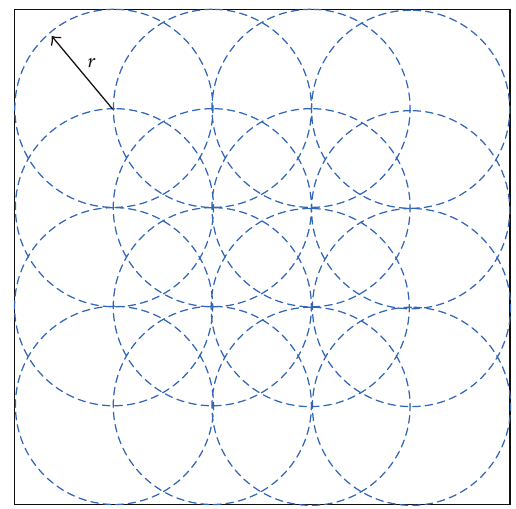
Figure 2: A typical structure partitioned to some same size full circular